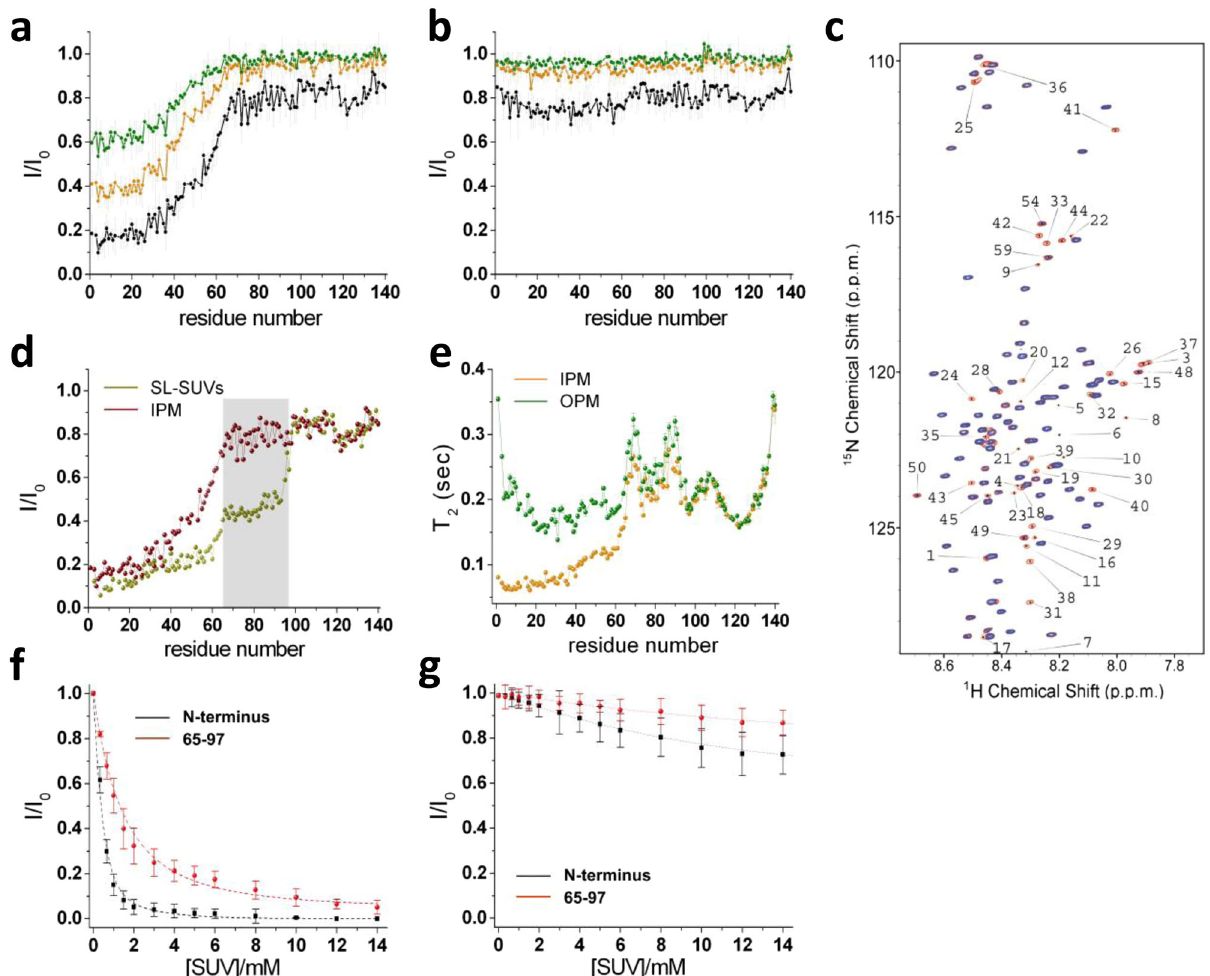
Fig. 1 α S binds IPM more strongly than OPM. Interaction between α S and IPM ( a ) and OPM ( b ) monitored using NMR CEST. Spectra were aquired at 283 K in 20 mM of phosphate buffer at pH 6.0, at a 1 H frequency of 700 MHz, using a protein and SUV IPM concentrations of 300 μ M and 0.06% (0.6 mg/ml), respectively. NMR CEST pro fi les measured using a saturation bandwidth of 350 Hz (Fig. S2 for measurements performed with a bandwidth of 170 Hz) and probing the interaction between α S and IPM ( a ) or OPM ( b ). Black, orange and green lines refer to the averaged CEST pro fi les measured using offsets at ±1.5, ±3.0, and ±5.0 kHz, respectively. Error bars report the standard deviation estimated on the triplicate measurements. c Representative 1 H- 15 N-HSQC CEST spectra of α S in the presence of IPM measured using a 350 Hz continuous wavelength at offsets of 100 kHz (red) and 1.5 kHz (blue). d Comparison of the interaction of α S with SL-SUVs 43 (yellow) and IPM (red) probed with NMR CEST pro fi les measured using a saturation bandwidth of 350 Hz and offsets of ±1.5 kHz. Data for the SL-SUVs binding 43 were measured at protein and lipid concentrations of 300 μ M and 0.06% (0.6 mg/ml), respectively. Grey background highlights the signi fi cant difference in the saturation of the region spanning residues 65 – 97, resulting in populations of detached conformations for this region of 51% and 95% for SL-SUVs and IPM, respectively. e T 2 values from transverse relaxation measurements (experimental conditions as in a , b ). Green and orange report T 2 values of α S in the presence of OPM and IPM, respectively. Error bars report the T 2 fi tting error. f – g Binding curves of α S to SUVs monitored via the signal attenuation of the peaks in the 1 H- 15 N-HSQC spectra of α S (50 μ M) as a function of the concentration of SUVs. The signal attenuations have been averaged across the residues of the N-terminal region (black) and the region spanning residues 65 – 97 (red) and error bars report the standard deviation of these values. In the case of IPM, the fi tting provided K D values of 5.2 μ M ( L = 14.3)